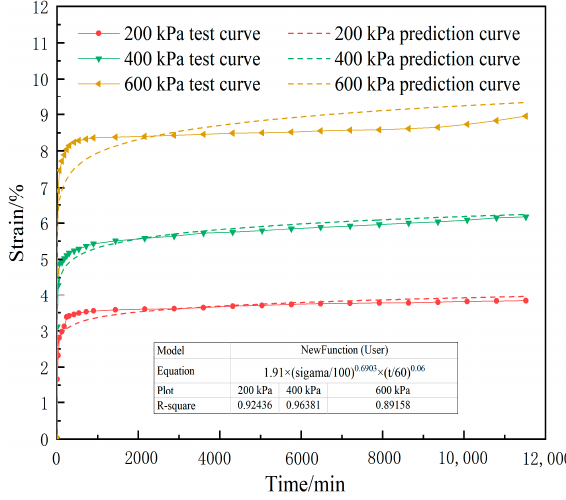
Figure 12. Comparison between prediction curve and test curve of silty clay.